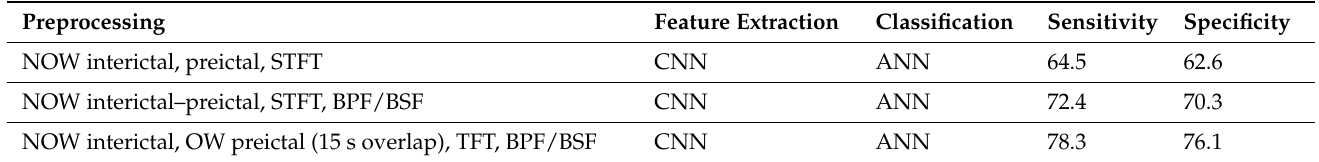
Table 3. Results of various preprocessing techniques used in the proposed